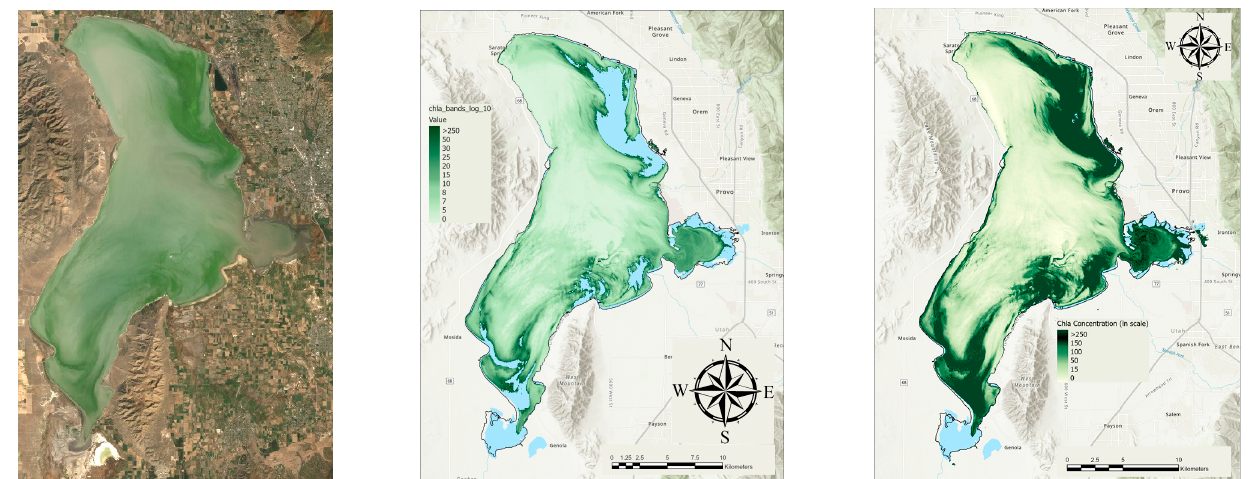
Figure 1. Example image from 24 September 1988 showing the issue with out-of-band pixels on the chl-a model. The left panel is a visual image, the center panel shows chl-a data with values over 300 µg/L clipped, and the right panel shows the image with the values over 300 µg/L set to 300 µg/L.